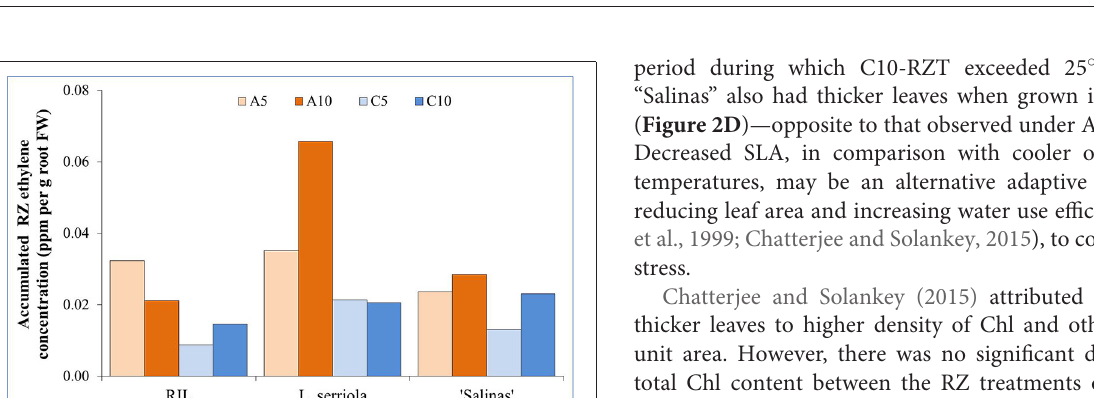
FIGURE 4 | Photochemical light use efficiency measurements of L. serriola , “Salinas” and RIL grown in A5, A10, C5, and C10. (A) Nonphotochemical quenching (NPQ), (B) photochemical quenching (qP) and (C) electron transport rate (ETR) at PPFD of 605 µ mol photon m − 2 s − 1 are shown. Each bar graph is the mean of 4 measurements from 4 different plants ( n = 4). Vertical bars represent standard errors. Different letters above the bar graphs denote statistical differences ( p < 0.05) as determined by Tukey’s multiple comparison test.